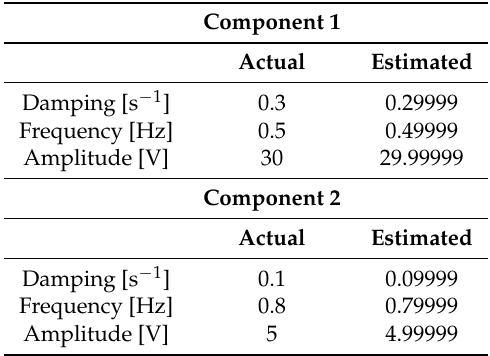
Table 1. Variable estimates after the third step of the proposed